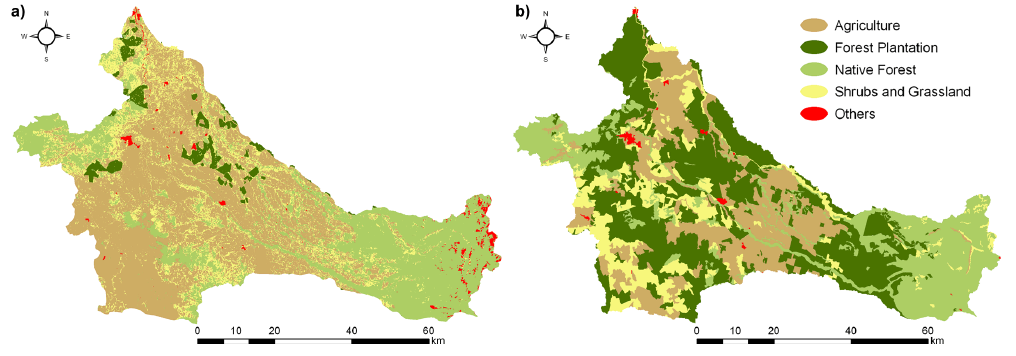
Fig. 3. Land cover in 1979 (left) and 1994 (right). Table 1. Curve number and Manning’s coeficient for the main land uses in the Vergara watershed. Parameter Description Forestry Native Agriculture Shrubs and plantation forest grassland 35 45 62